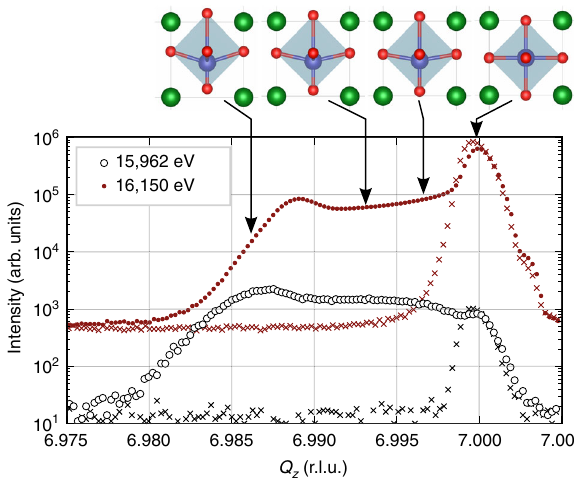
Fig. 6 The 007 re fl ection pro fi les of SrTiO 3 before and after formation of the MFP phase. The maximum on the right hand side corresponds to cubic (bulk) SrTiO 3 and is the only feature under normal conditions (crosses). After formation (circles), a shoulder peak is observed at lower momentum transfer Q z , which is associated with the MFP phase. The intensity ratio of both peaks is very different when measured at two different energies near the Sr- K edge – 15,962 eV (black) and 16,150 eV (red, shifted to top). This can be explained by a change of the relative, crystallographic positions of the atoms. These atomic displacements were obtained from fi tting the energy dependencies (see Fig. 7). The unit cells in the top of the fi gure (green: strontium, blue: titanium and red: oxygen) show the displacements enhanced by a factor of 10 for better visibility. Arrows mark values for which fi xed Q energy scans have been recorded